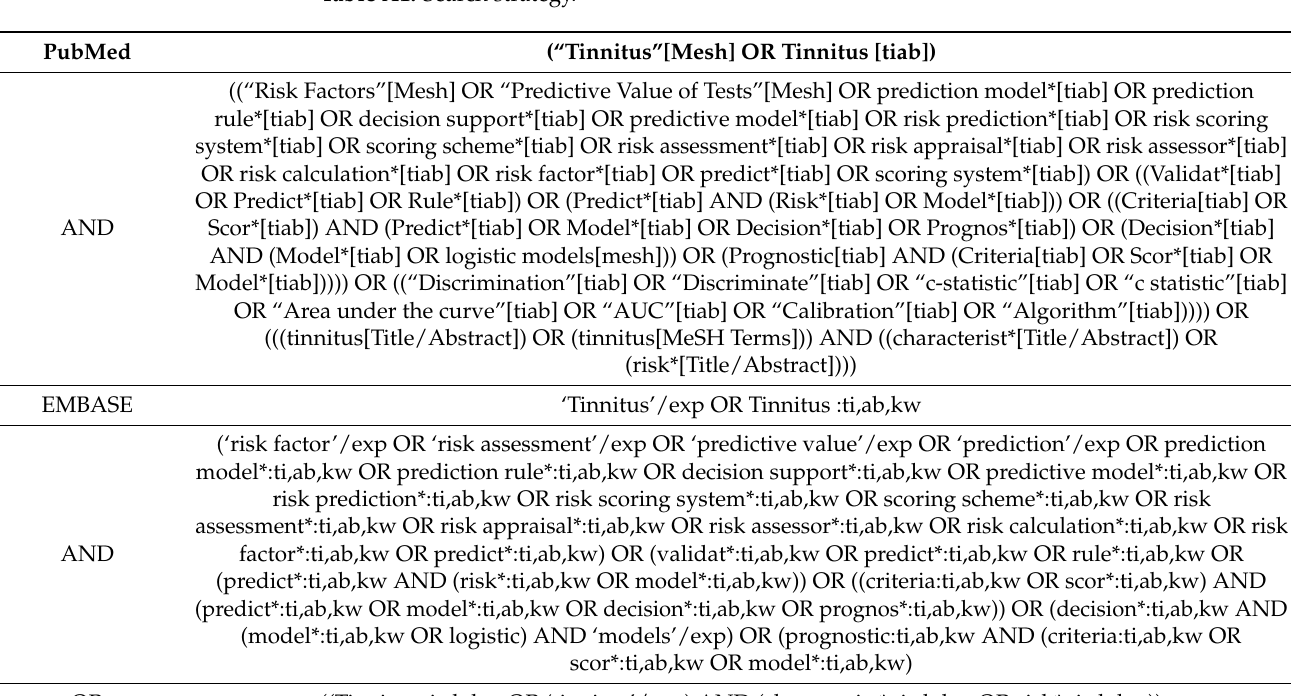
Table A1. Search strategy.